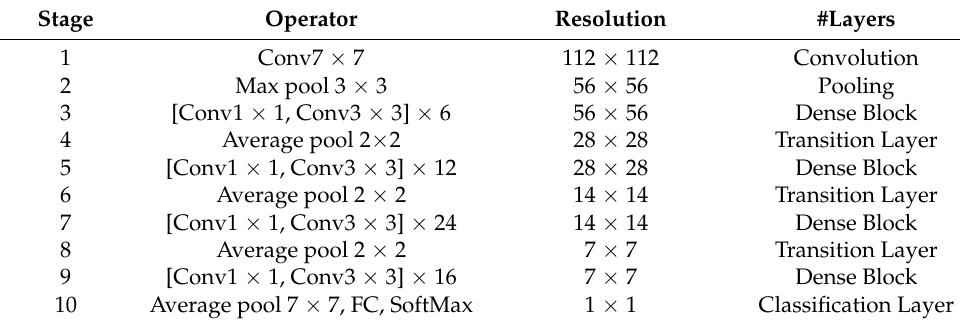
Table 8. Detailed configuration of the